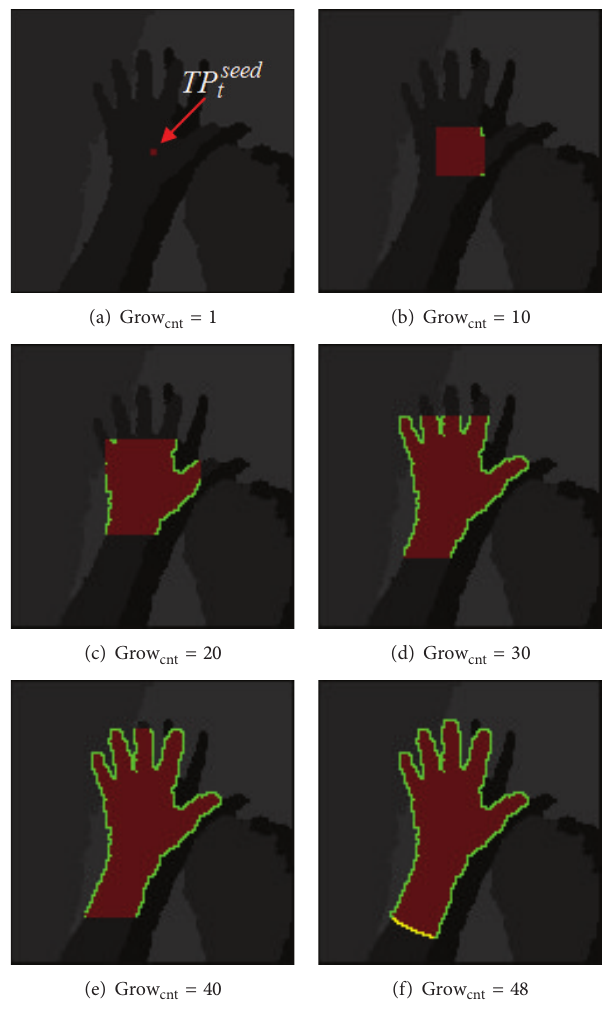
Figure 9: Result of region